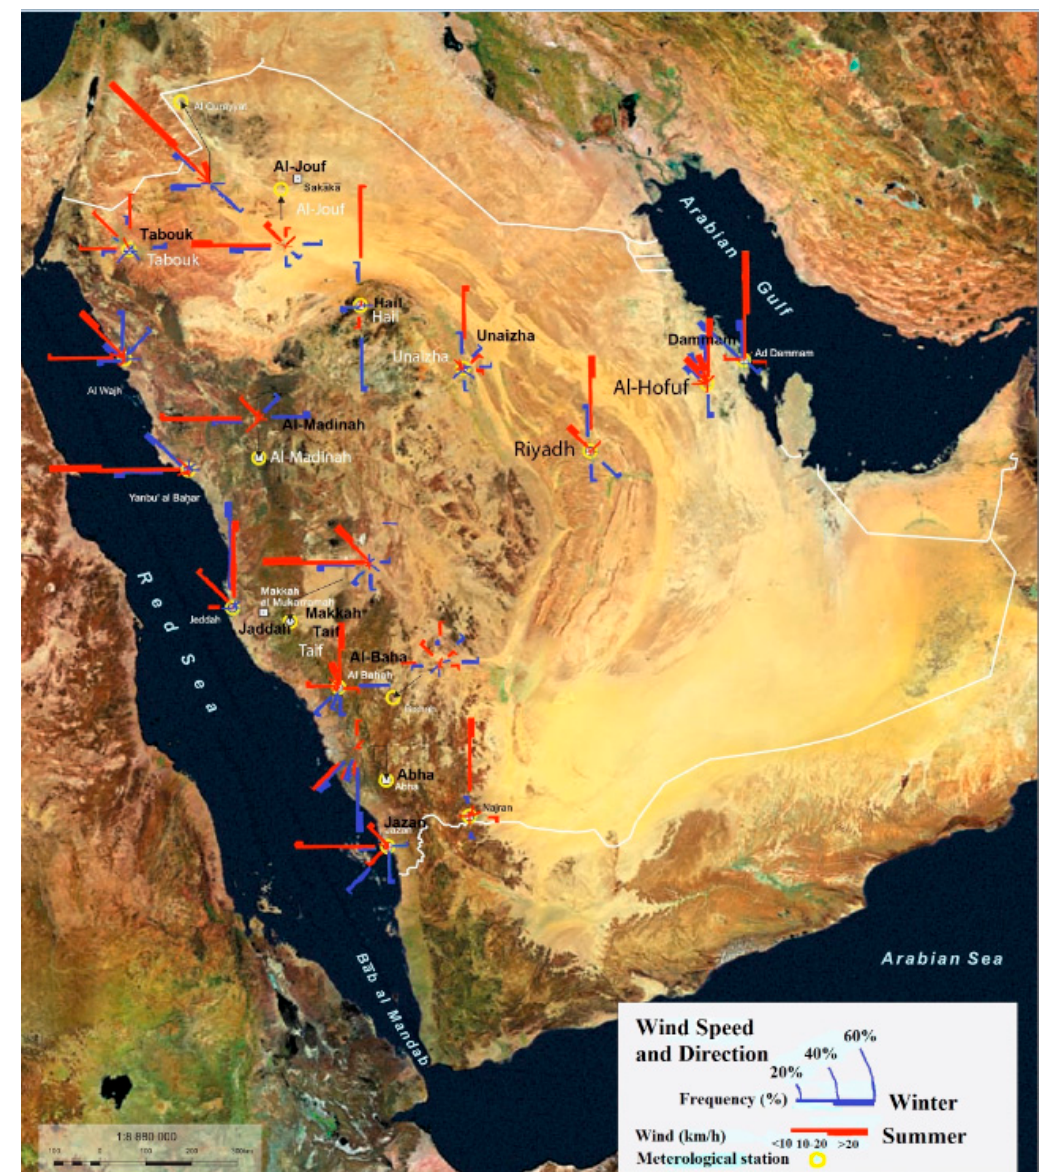
Figure 1. Locations of 14 weather stations in Saudi Arabia included in the current study. The arrows in red and blue colors show the wind directions in summer and winter respectively. Central region (Riyadh, Unaizah); North region (Hail, Al-Jouf and Tabouk); Southwest region (Abha, Al-Baha and Jazan); Eastern region (Dammam and Al-Hofuf); and Western region (Jeddah, Taif, Makkah and Al-Madinah).